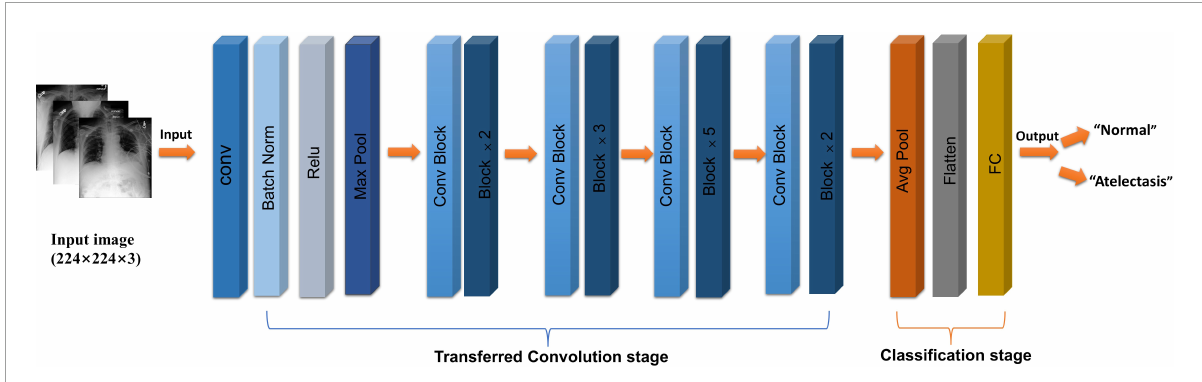
FIGURE2 Flow chart of ResNet50 (CoNV is convolution operation, Batch Norm is Batch regularization processing, ReLU is activation function, MAXP00L and AvgPOOL are two pooling operations, including convolution transformation stage, and classification stage, respectively).